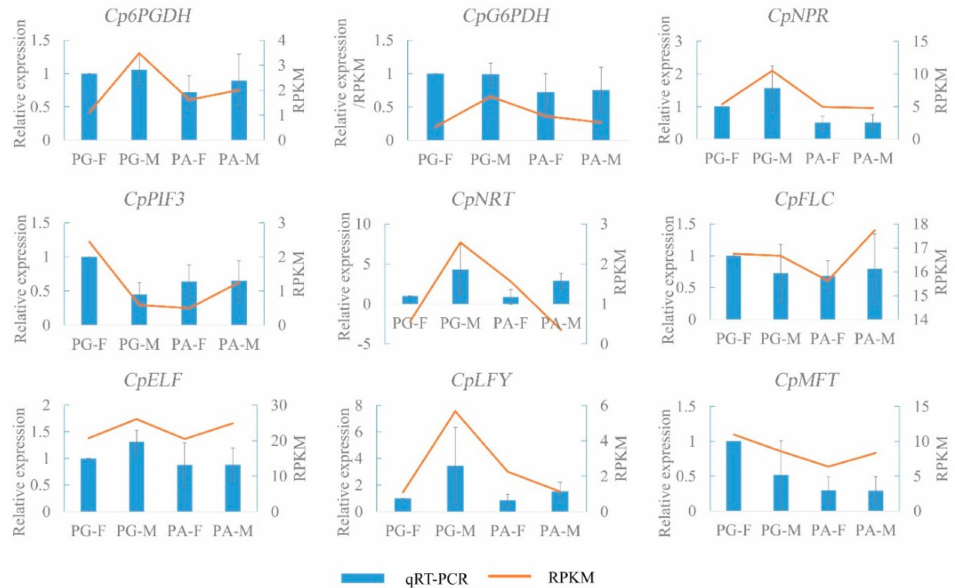
Figure 9. Comparison of expression levels of 9 genes obtained by qRT-PCR analysis and RNA-seq (RPKM (Reads per kilobase million mapped) values). The error bar is SD (standard deviation) for the three